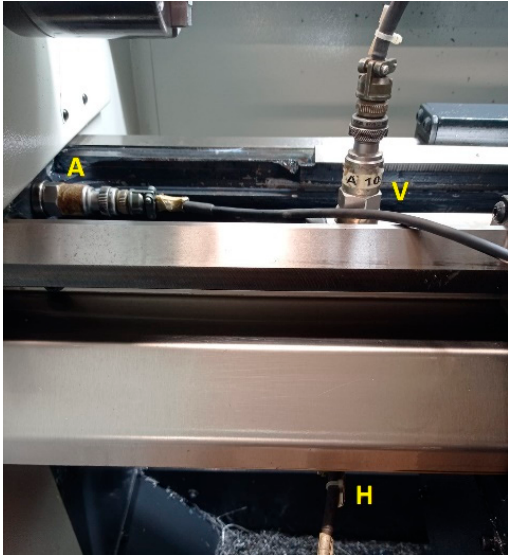
Figure 2. Accelerometers mounted on the lathe bed.